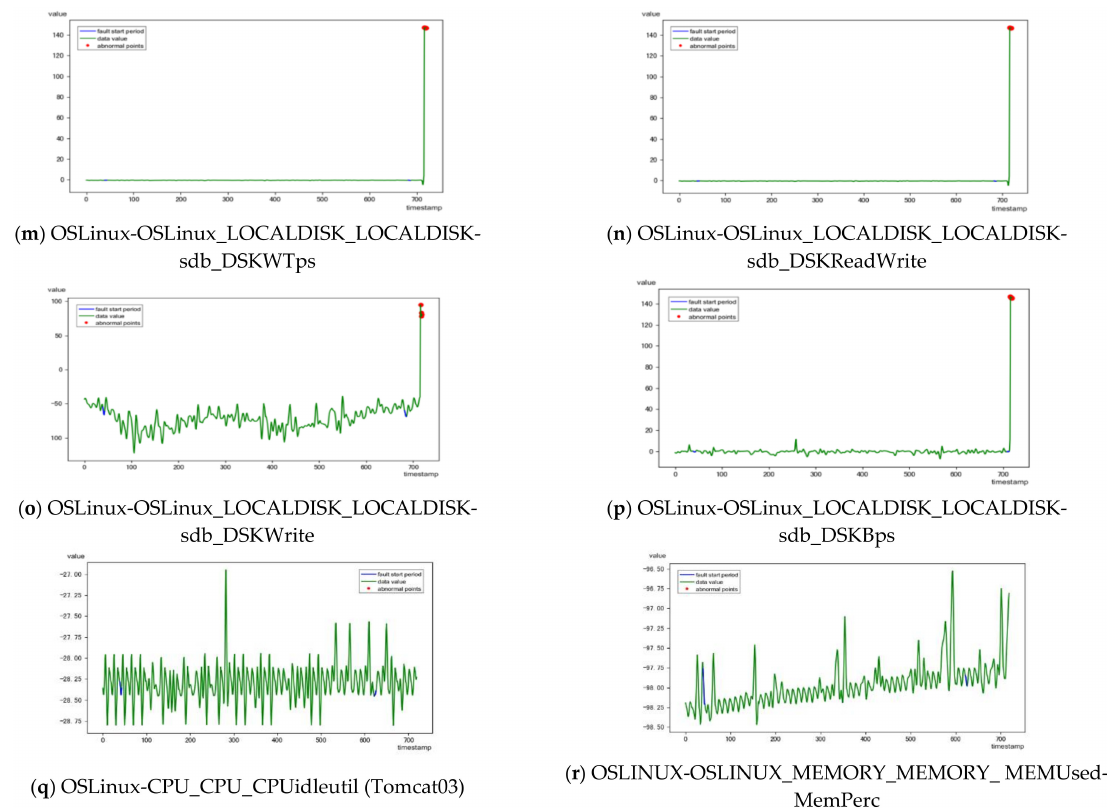
Figure 5. KPI curve of abnormal nodes detected during fault period. ( a – r ) The anomaly detection results of 18 KPIs in two periods. The red nodes represent the anomaly point, and the two blue lines represent the starting times of two different faults.